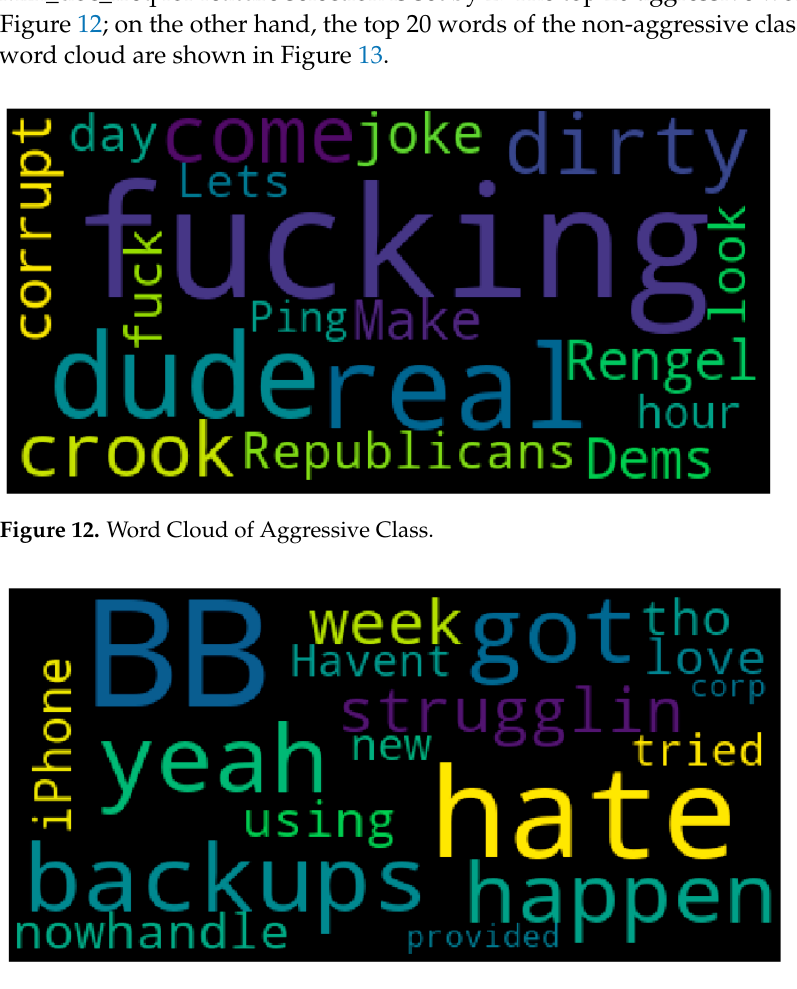
Figure 13. Word Cloud of Non-Aggressive Class.